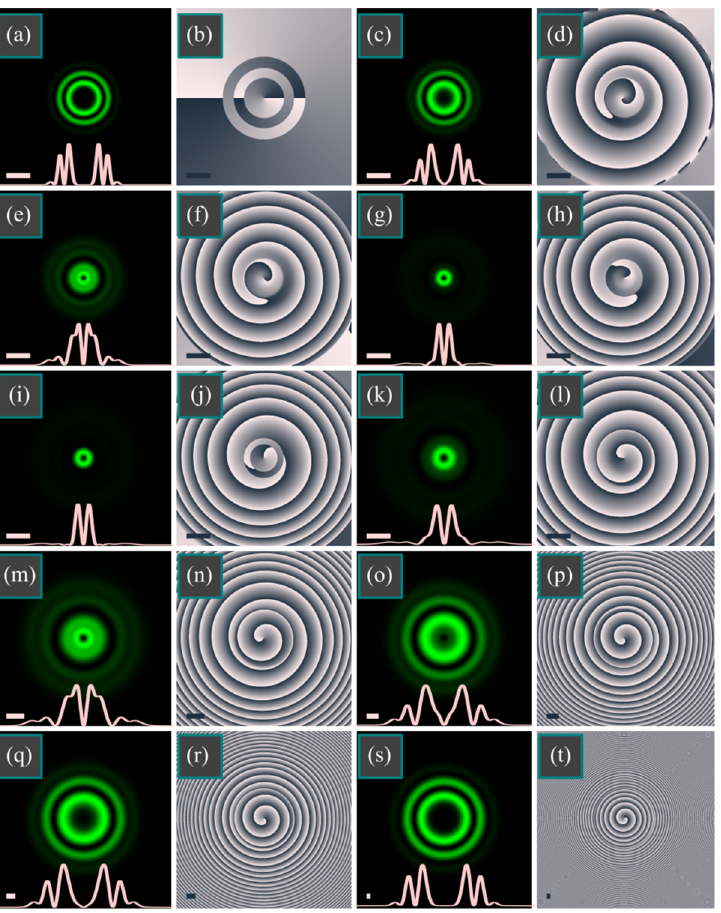
Figure 1. Intensity (columns 1 and 3) and phase distributions (columns 2 and 4) of the LG beam from Equation (1) in different transverse planes z / z 0 = 0 ( a , b ), 1/4 ( c , d ), 1/2 ( e , f ), 3/4 ( g , h ), 1 ( i , j ), 1.5 ( k , l ), 2 ( m , n ), 3 ( o , p ), 4 ( q , r ), 10 ( s , t ). Other computation parameters are: wavelength λ = 532 nm, waist radius of the Gaussian beam w = 0.5 mm, azimuthal (upper) and radial (lower) indices of the associated Laguerre polynomial are m = 4 and n = 3, respectively. Plots in the intensity distributions show the intensity cross-sections. Scale marks in the left lower corners (light in columns 1 and 3 and dark in columns 2 and 4) show 1 mm.